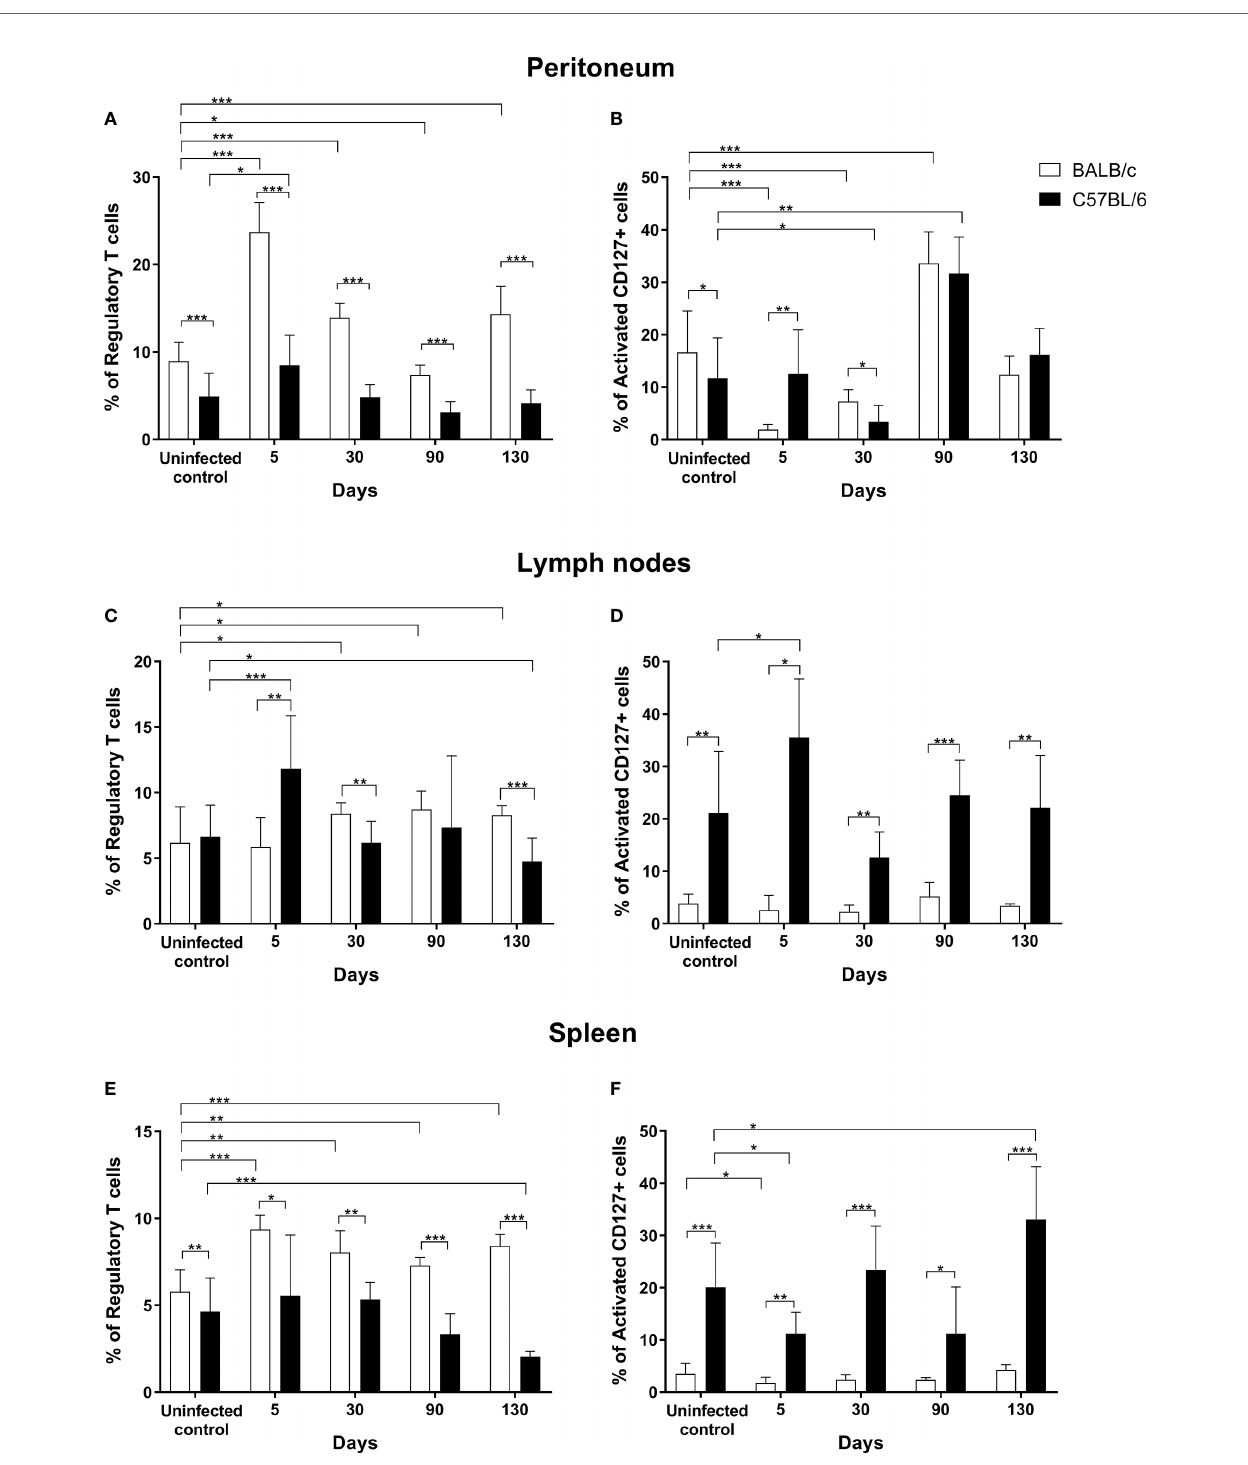
FIGURE 1 | Infection by Taenia crassiceps led to increased Treg percentages in the susceptible strain BALB/cAnN (white bars) but not in the resistant strain C57BL/6 (black bars). The percentage of regulatory T cells and activated CD127+ cells is shown in peritoneum (A, B) , lymph nodes (C, D) and spleen (E, F) from BALB/cAnN and C57BL/6 mice. Six infected mice and 6 controls were included for each time point analyzed. Flow cytometry results are reported as a mean and standard deviation (bar graph). Signi fi cant differences in cell percentages as determined by the U Mann- Whitney test are shown as * P < 0.05, ** P < 0.01, and *** P <